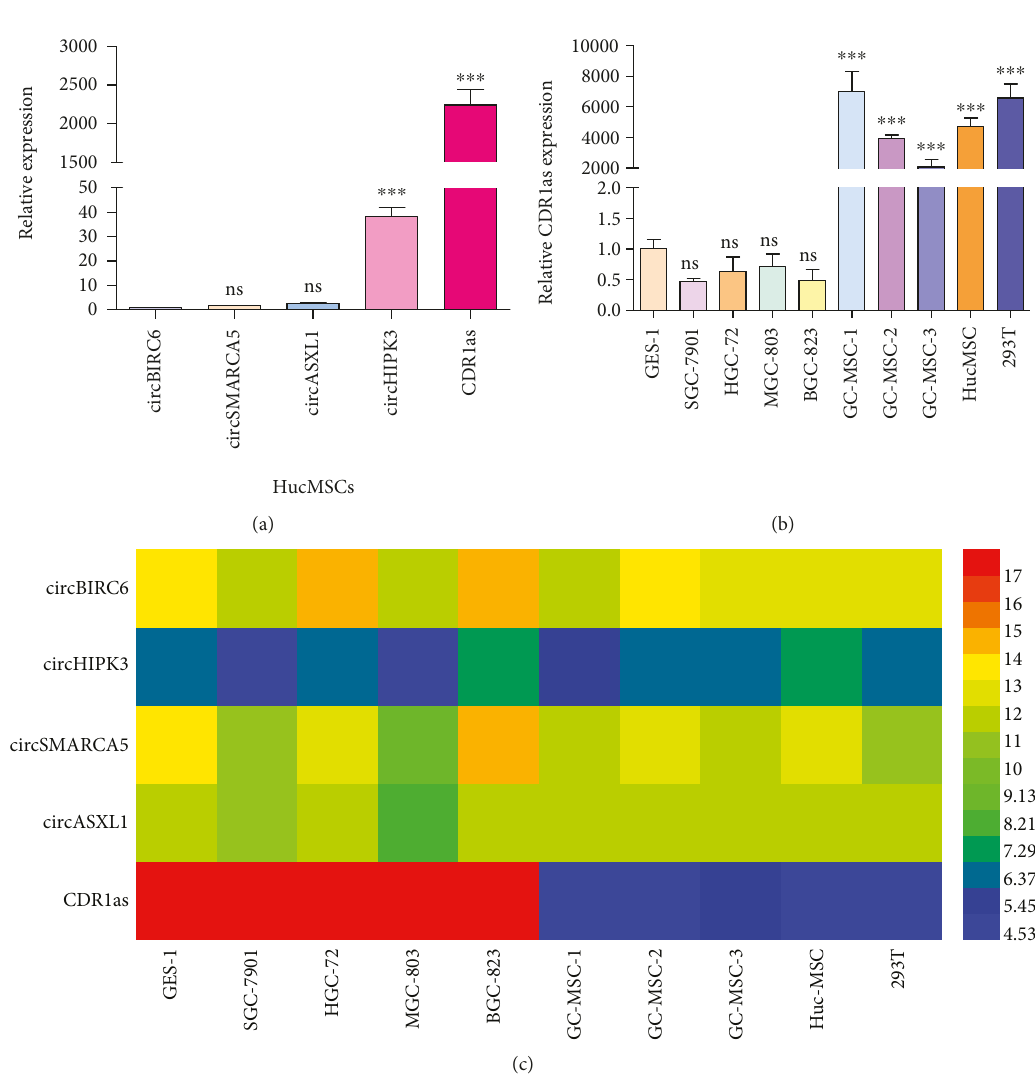
Figure 1: CDR1as was highly expressed in hucMSCs. (a) Using RT-qPCR, the relative expression levels of circRNAs in hucMSCs were detected. (b) RT-qPCR was used to analyze the expression level of CDR1as in di ff erent cells. (c) Heat map of RT-qPCR data (relative expression values Δ CT ) for showing the expression levels of circRNAs in di ff erent cell lines. CircRNA with a higher expression level is mapped to the blue part and a lower expression level is mapped to the red part. ns: no signi fi cance; ∗ P < 0 05 ; ∗∗ P < 0 01 ; ∗∗∗ P < 0 001